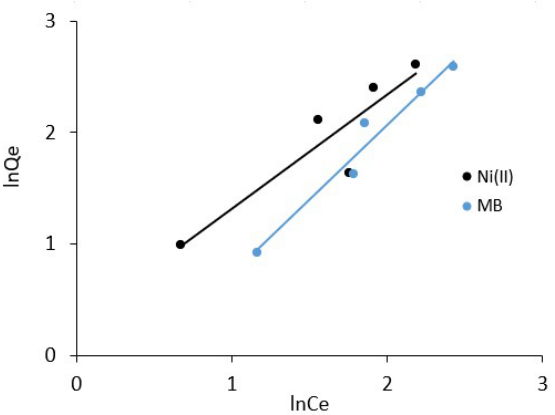
Fig.9. Freundlich adsorption isotherm for removal of Ni(II) ions and MB onto natural